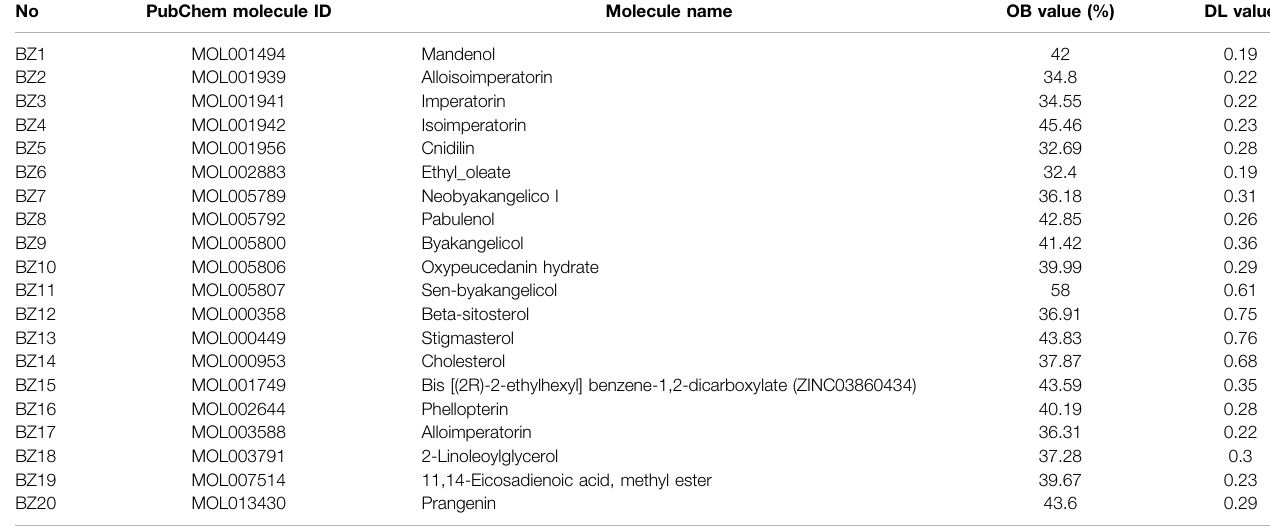
TABLE 1 | Showing the 20 active compounds from A. dahurica and their corresponding predicted oral bioavailability (OB) and drug-likeliness (DL).